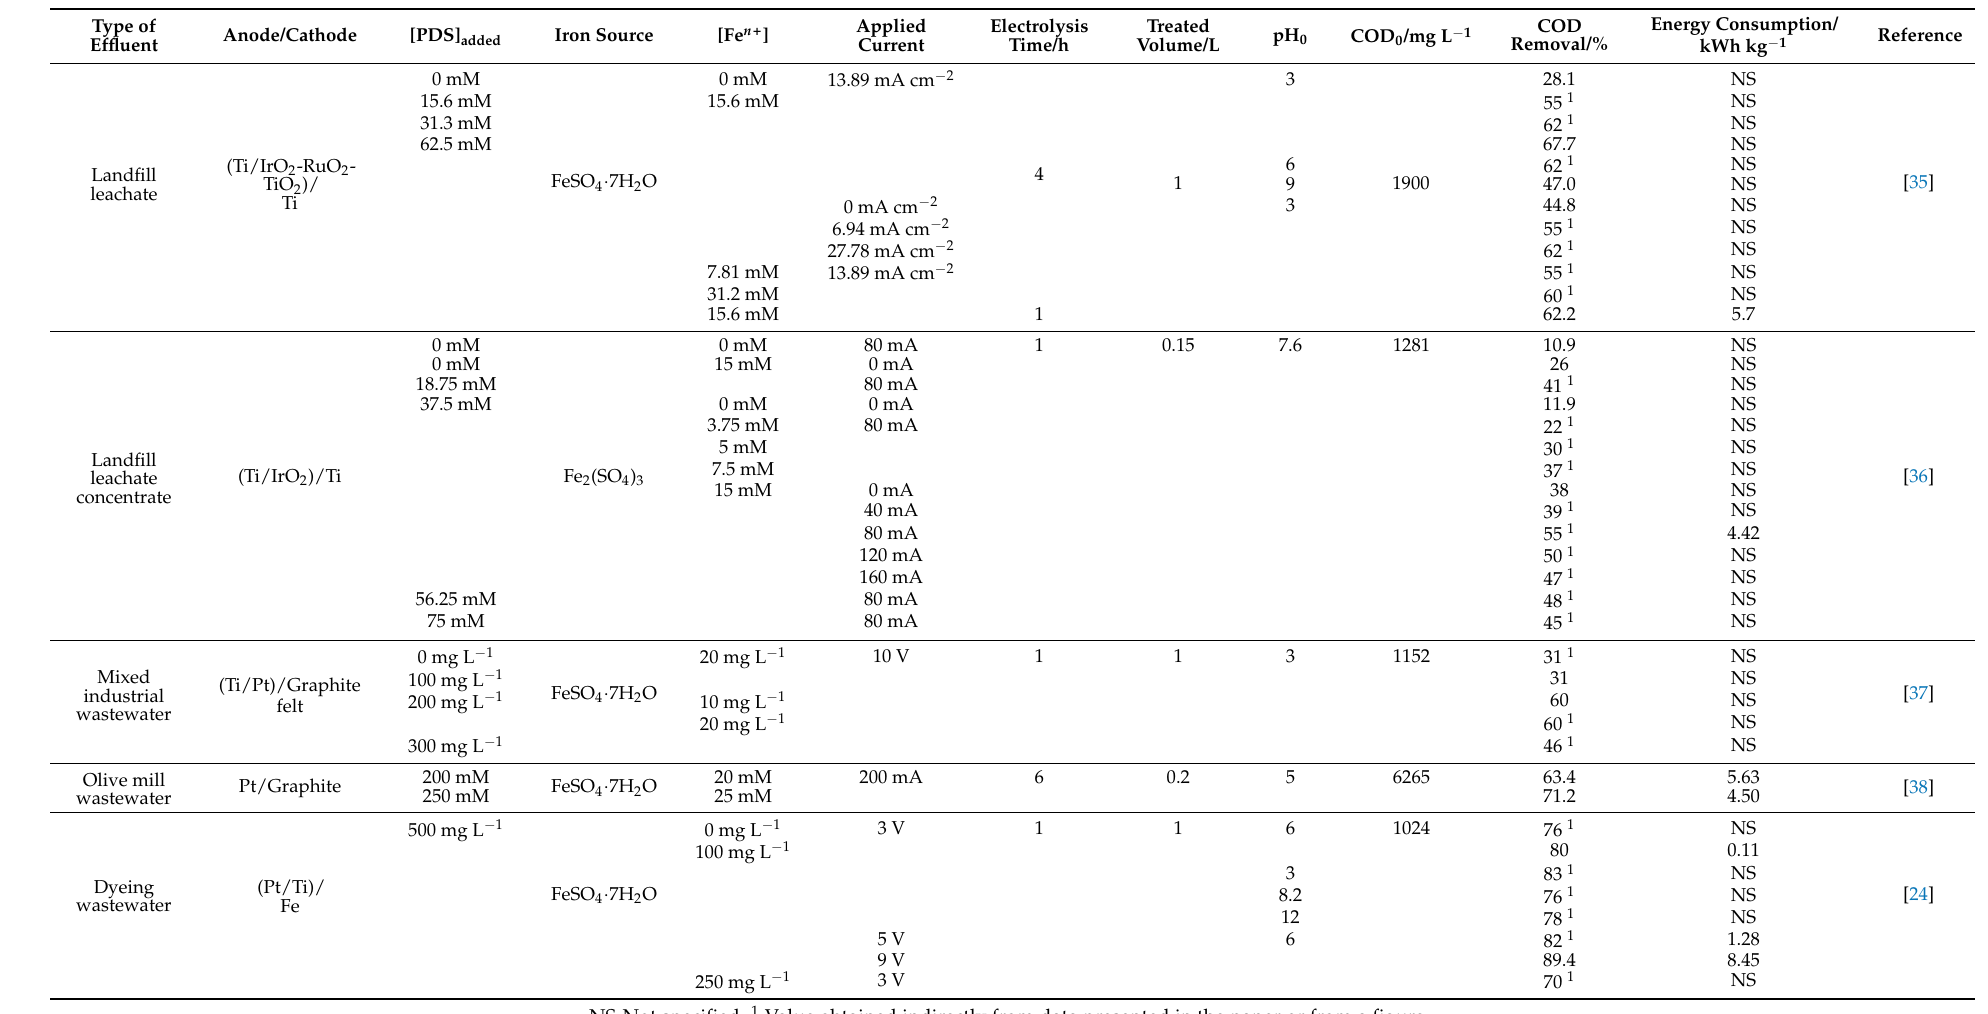
Table 3. Summary of research results previously reported for persulfate electro-activation with metal ions addition in the treatment of complex